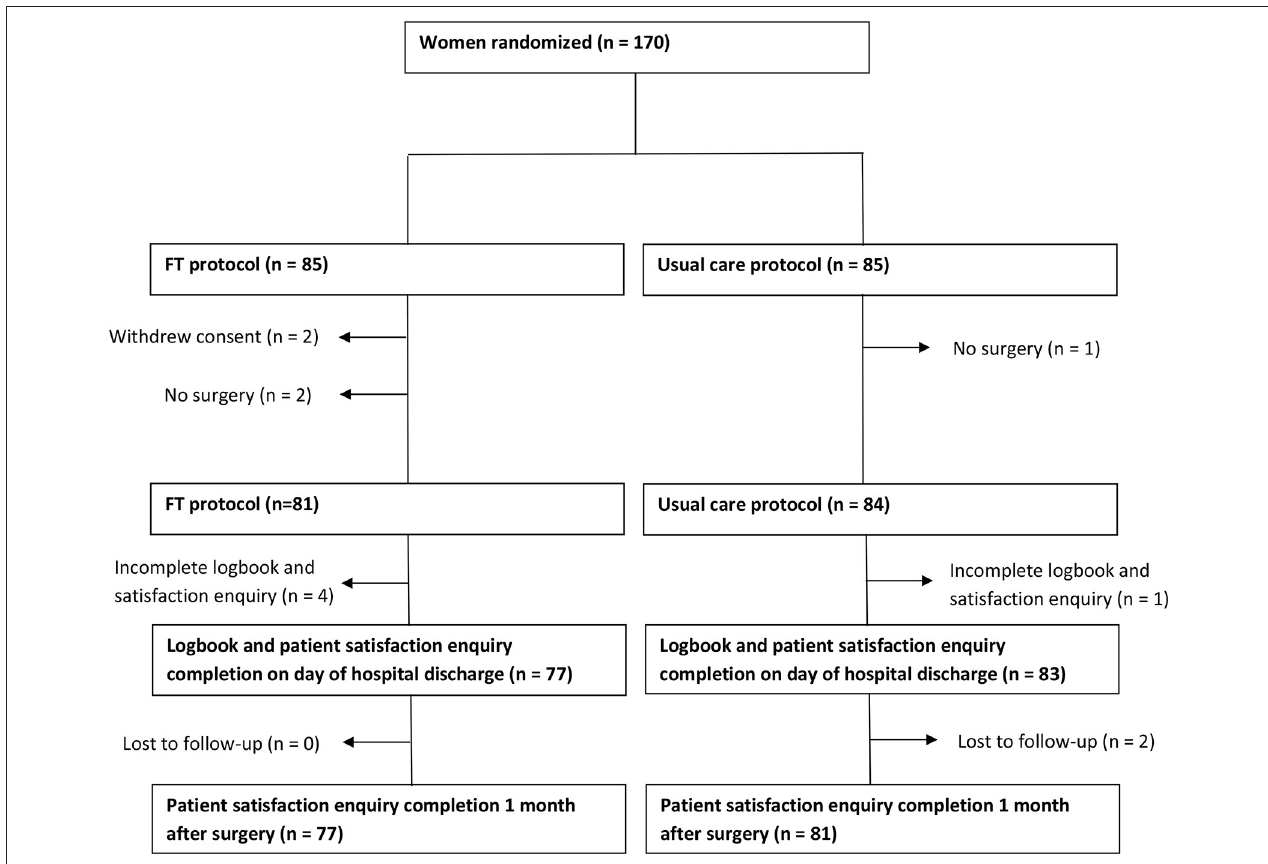
FIGURE 2 | Study flowchart. FT,